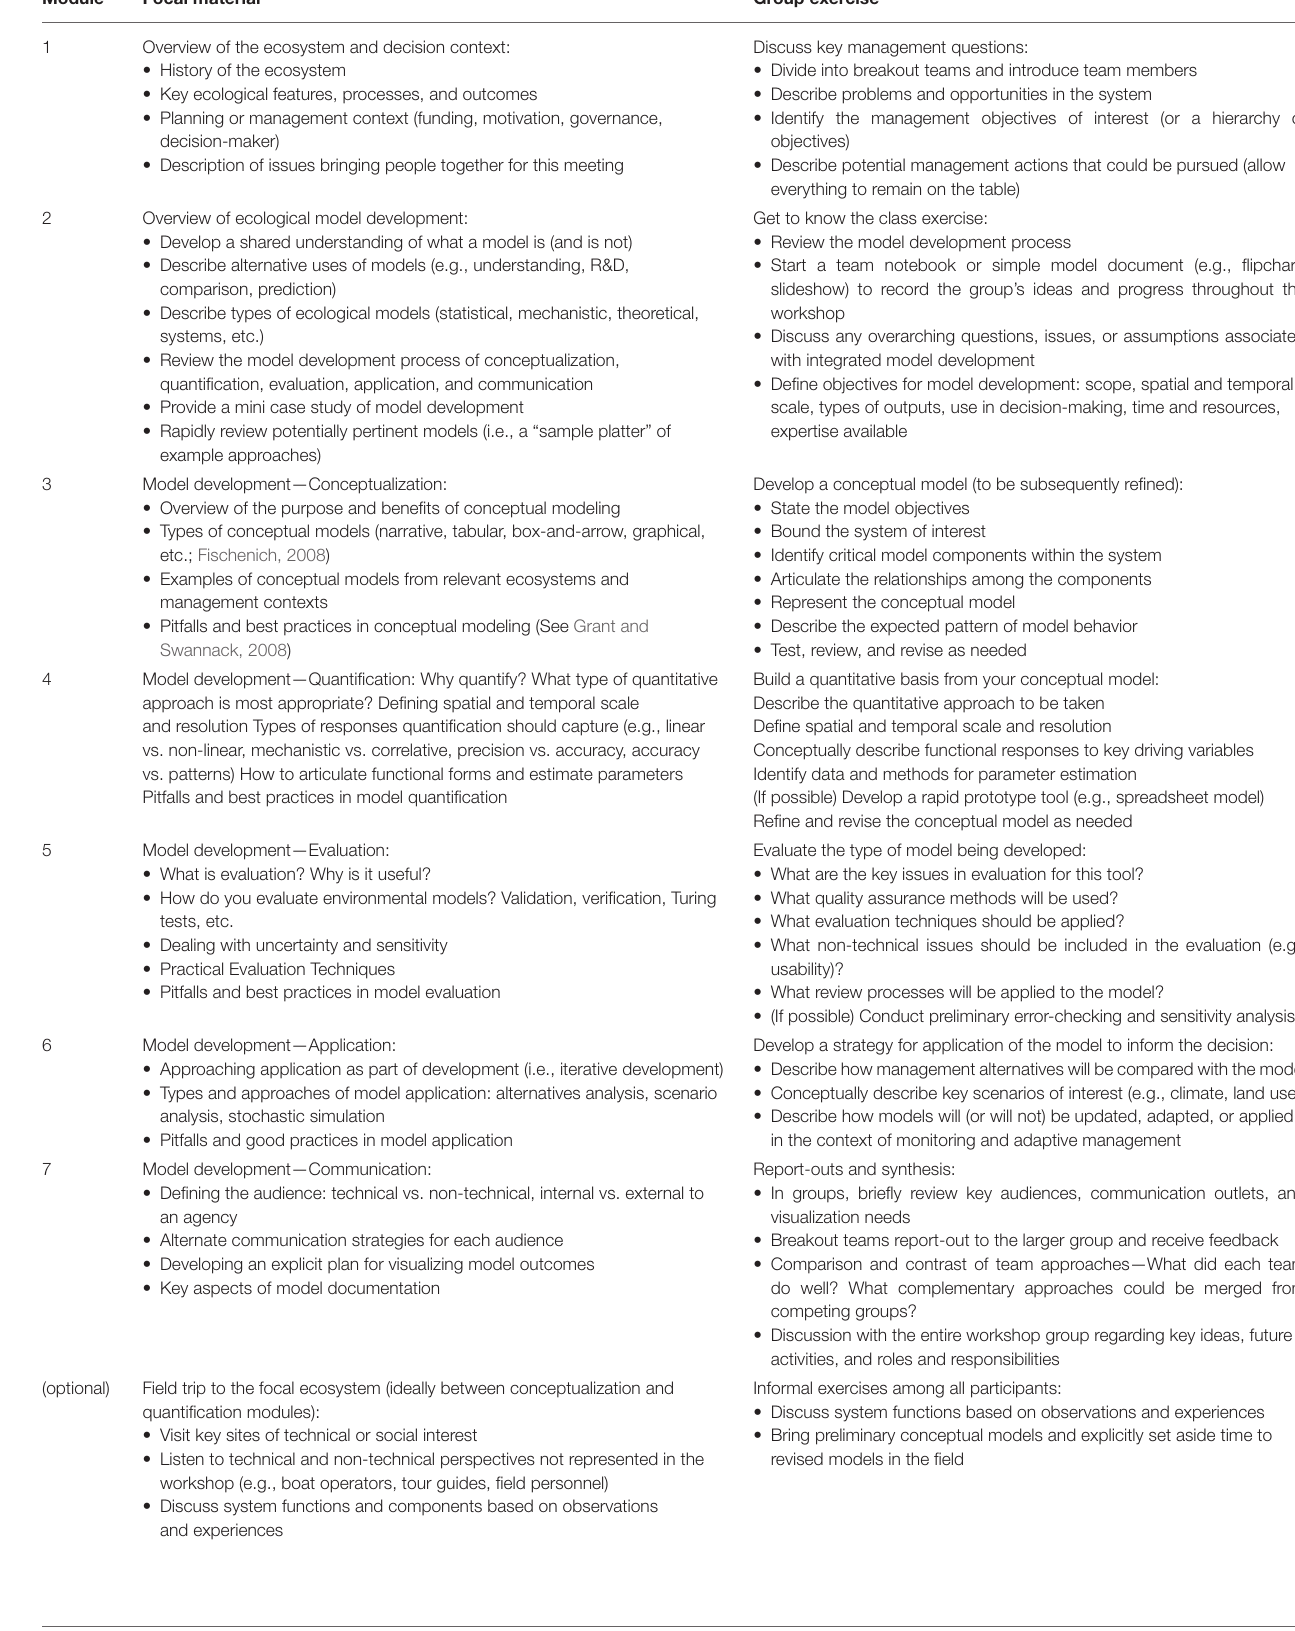
TABLE 2 | Mediated model development workshop content, learning objectives, and facilitated exercises. Module Focal material Group